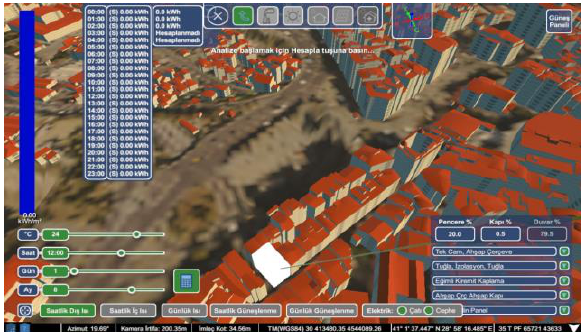
Figure 18. Selection of a particular building to be calculated, single LoD.